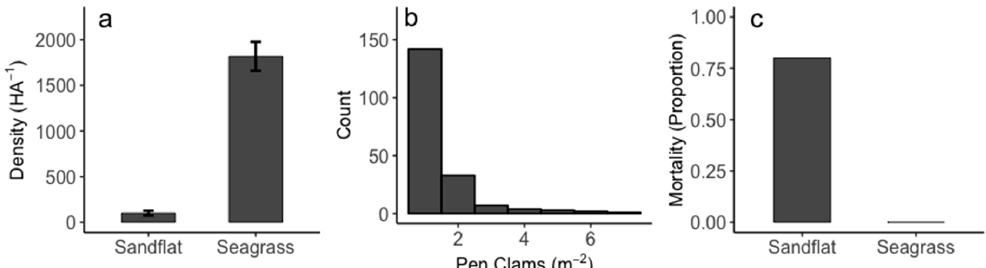
Figure 2. Pen clam ( a ) distribution and density from surveys of 13 seagrass beds and adjacent sandflats, ( b ) histogram of observed pen clam occurrences, and ( c ) observed mortality and location of transplanted pen clams. Error bars represent standard errors.